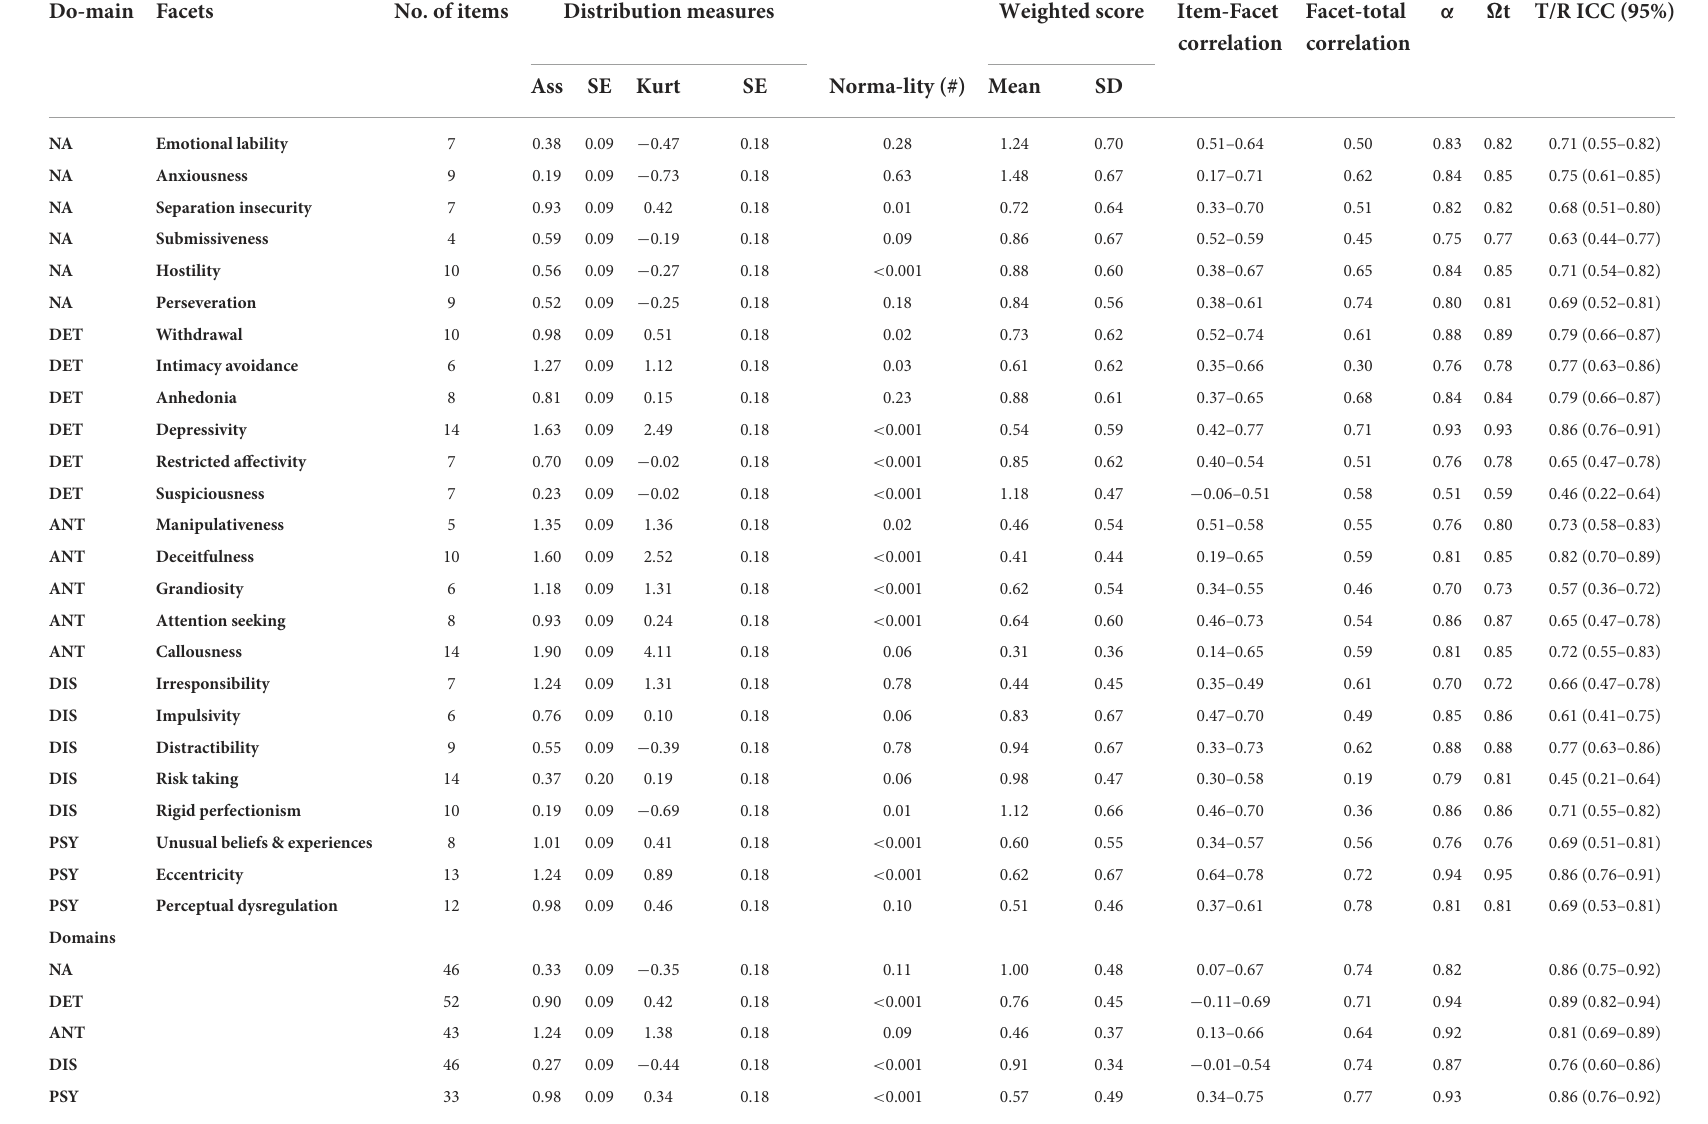
TABLE 1 Raw and weighted scores, distribution measures, correlations, and reliability indicators of PID-5 (paper-and-pencil) facets and domains, ( N = 730). Do-main Facets No. of items Distribution measures Weighted score